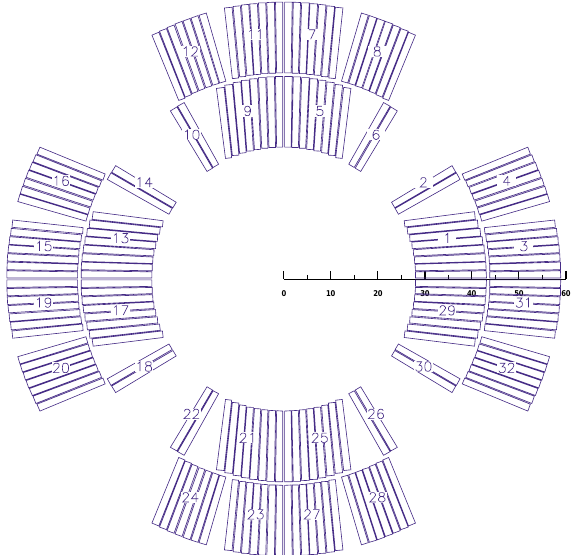
FIG. 6. (Color) Cross section of the four-block LHC quad- rupole coil.